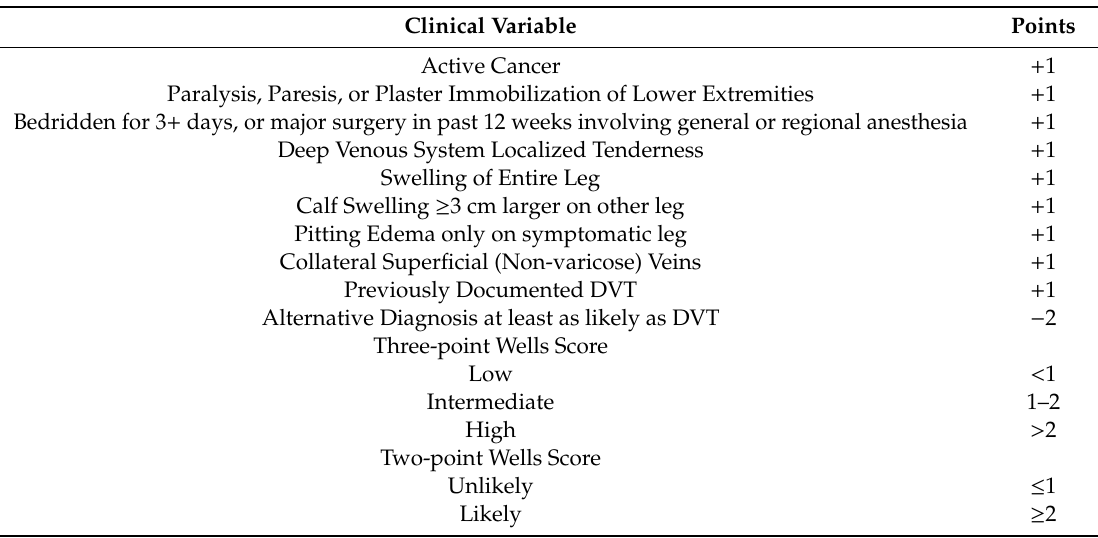
Table 2. Well score (clinical decision rule for